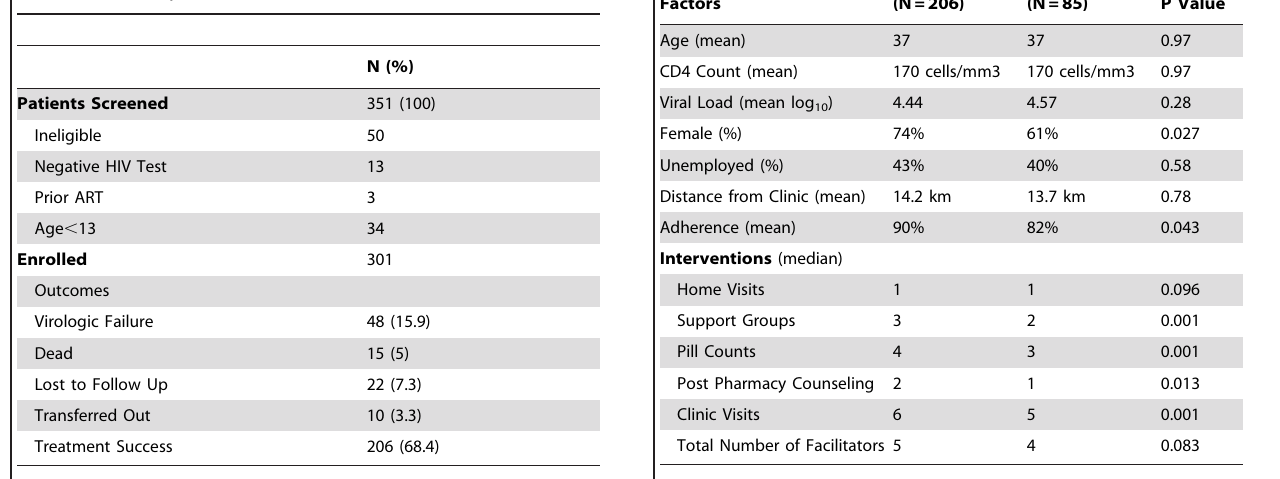
Table 1. Participant Flow and Outcomes.